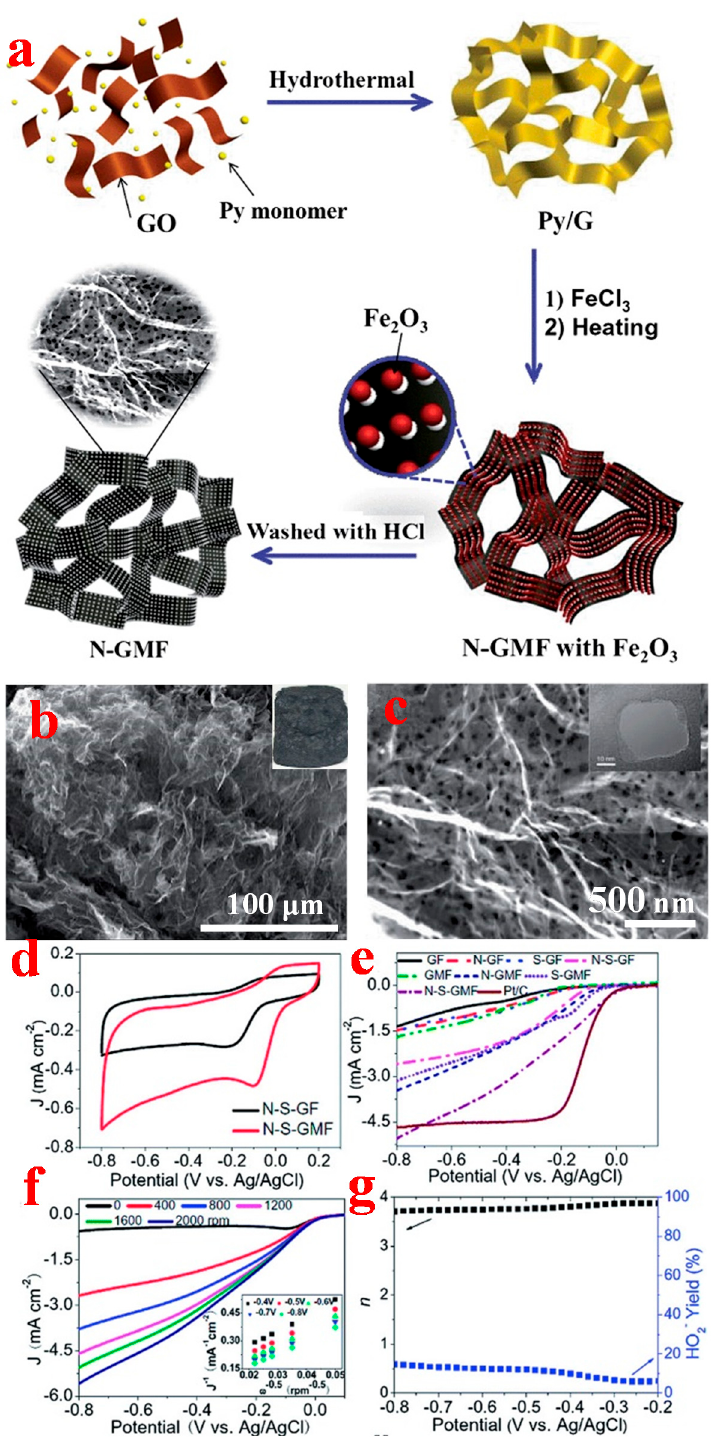
Figure 9. ( a ) Schematic charts for the synthesis of N-GMF (nitrogen-doped graphene nano-mesh foam); ( b ) SEM images of N-GMF; the inset is the photo of N-GMF; ( c ) scanning transmission electron microscopy (STEM) image of N-GMF; the inset is the TEM image of a single nano-hole with high magnification; ( d ) CV curves of N-S-GMF (N and S co-doped graphene nano-mesh foam) and N-S-GF (N and S co-doped graphene foam) in O 2 -saturated 0.1 M KOH solution; ( e ) LSV curves of different electrocatalysts (1600 rpm); ( f ) rotating disk electrode (RDE) measurement of N-S-GMF in O 2 -saturated 0.1 M KOH with different rotating speeds; the inset shows the K-L plots from LSVs; ( g ) the n and HO 2 − production of the N-S-GMF. Reproduced from [125] with permission from The Royal Society of Chemistry. Copyright 2014.